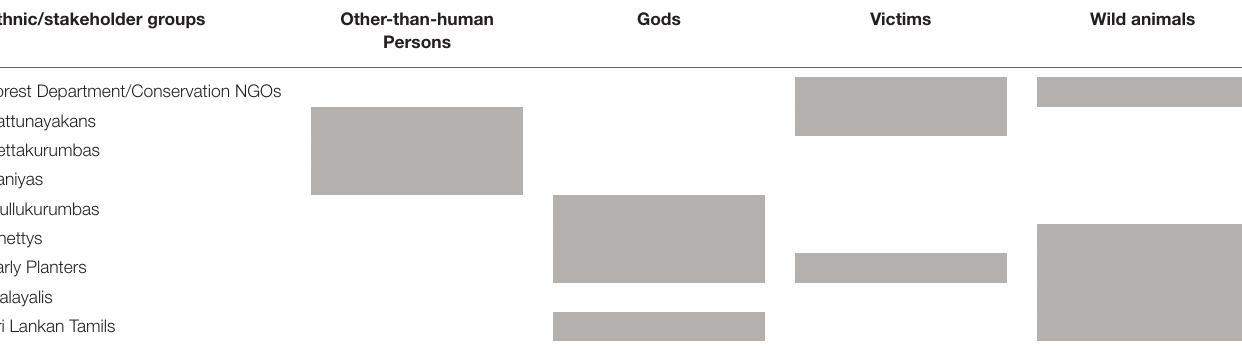
TABLE 4 | Varied beliefs about